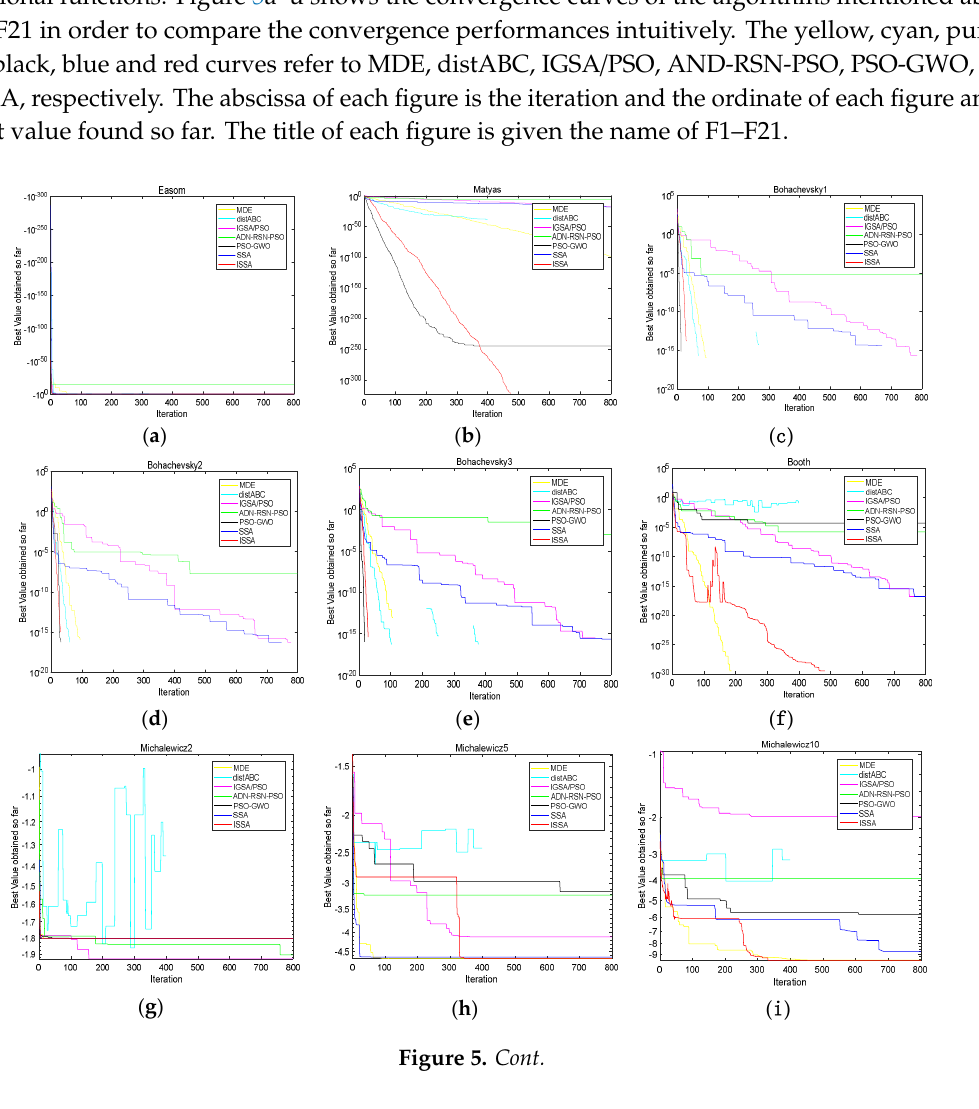
Table 13. The results of the Holm test.